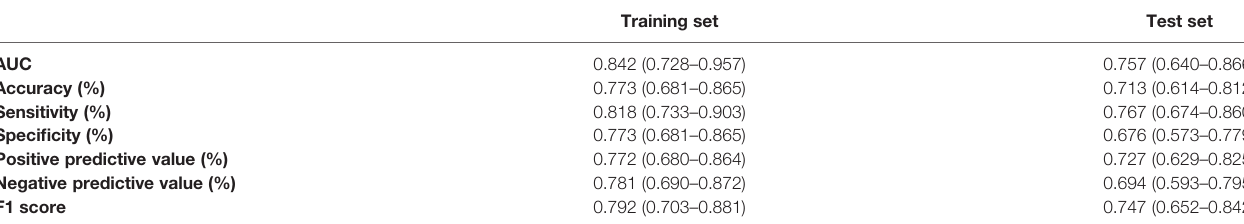
The range of values in parentheses indicates the 95% CI. AUC, area under the